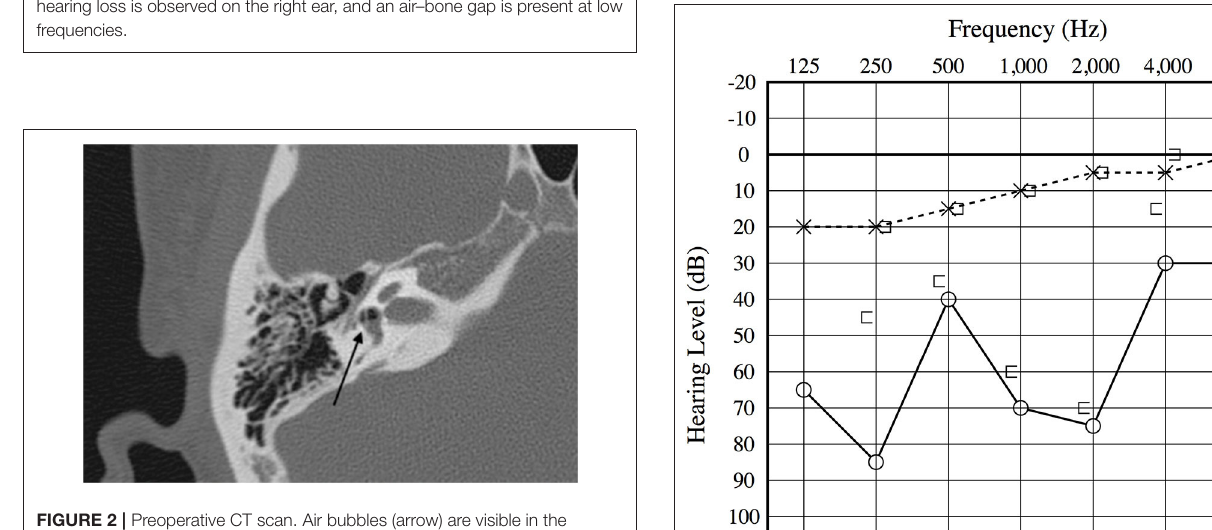
FIGURE 2 | Preoperative CT scan. Air bubbles (arrow) are visible in the vestibule.